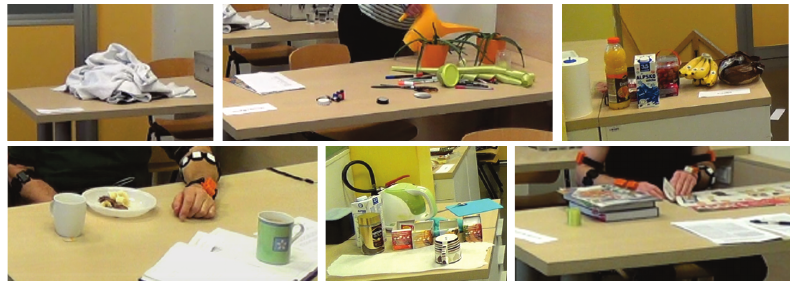
Figure 1. Activities of daily living included preparing a meal, chatting and drinking coffee or tea, watering flowers, folding and tidying towels, writing a shopping list, reading a newspaper, and tidying up a